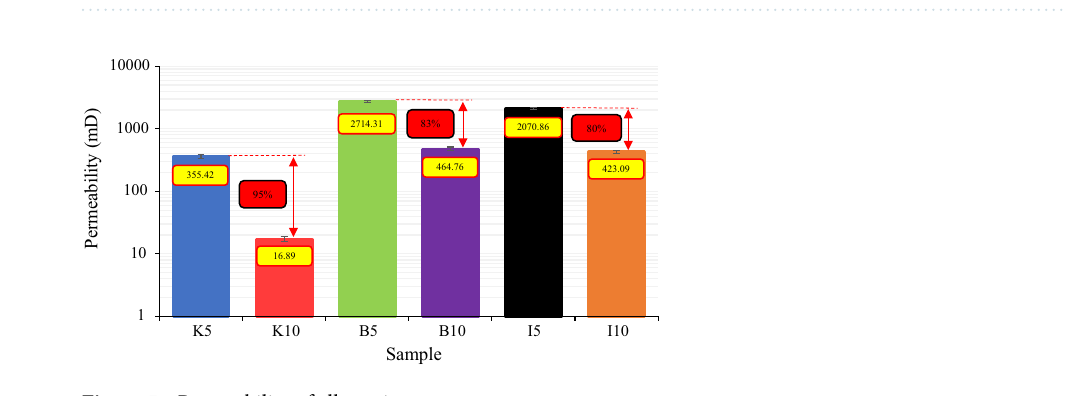
Figure 5. Permeability of all